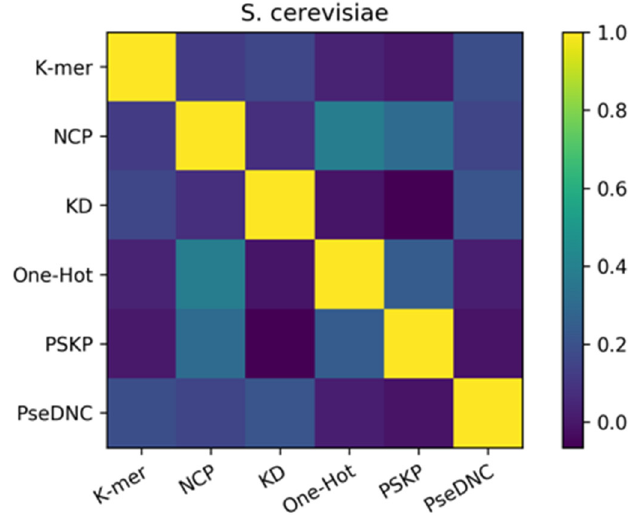
Figure 5. Pearson correlation coefficients of the feature descriptors on the S. cerevisiae dataset. The shades of color indicate the strength of similarity between the six basic predictors, with the darker color indicating weaker correlations.